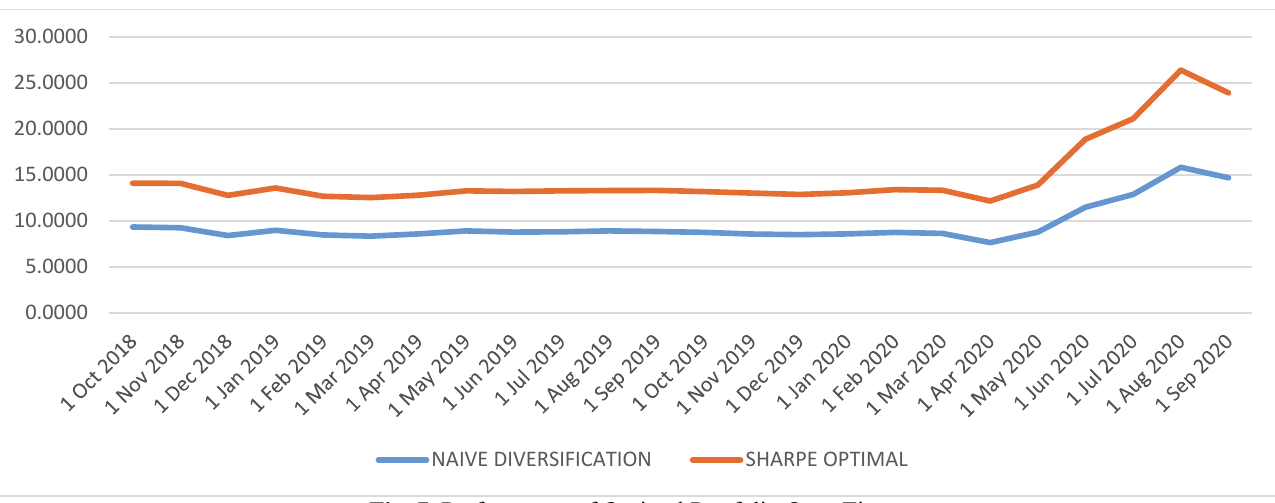
Fig. 7. Performance of Optimal Portfolio Over